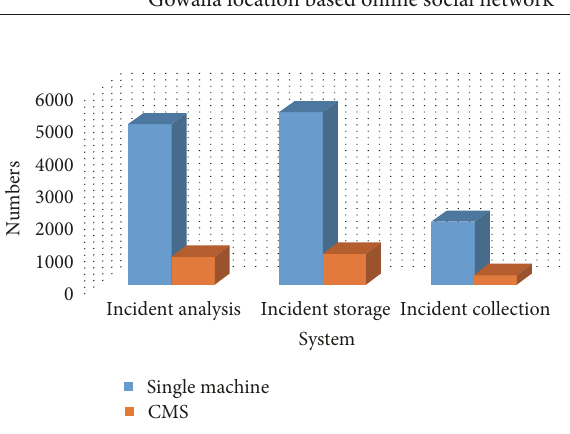
Figure 5: The comparison of the abilities on different systems.